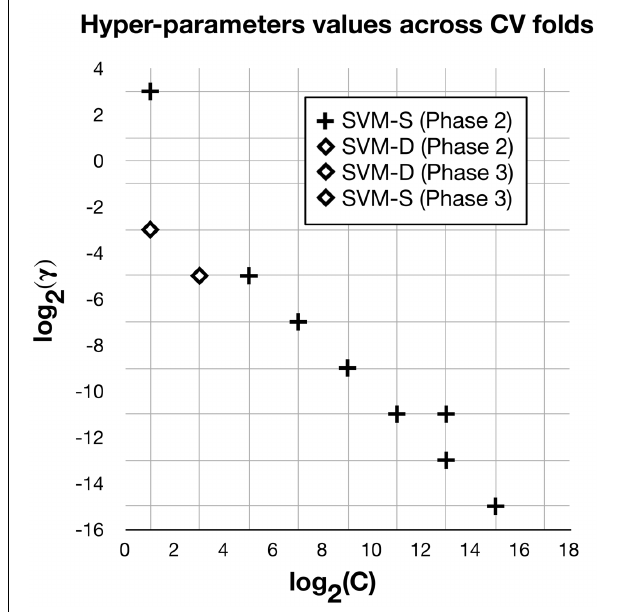
FIGURE A1 | This plot shows the hyper-parameters values C and γ selected (not showing repetitions) at different iterations of the outer cross-validation loop for the SVMs built in Phases 2 and 3. SVM-D (in Phases 2 and 3) and SVM-S (in Phase 3) have relatively stable hyper-parameter values across cross-validation folds, while SVM-S (in Phase 2) can vary between eight sets of